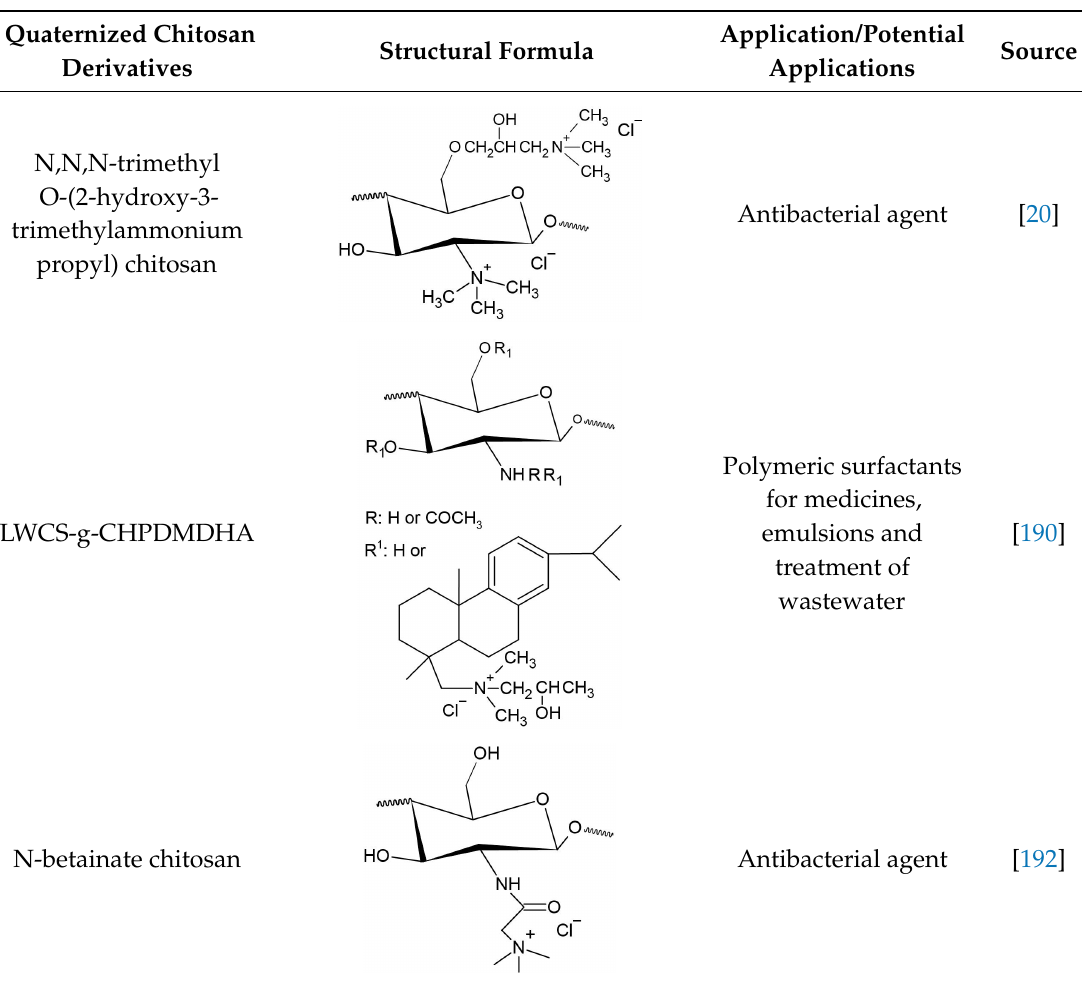
Table 1. Structural formulae of the other quaternized chitosan